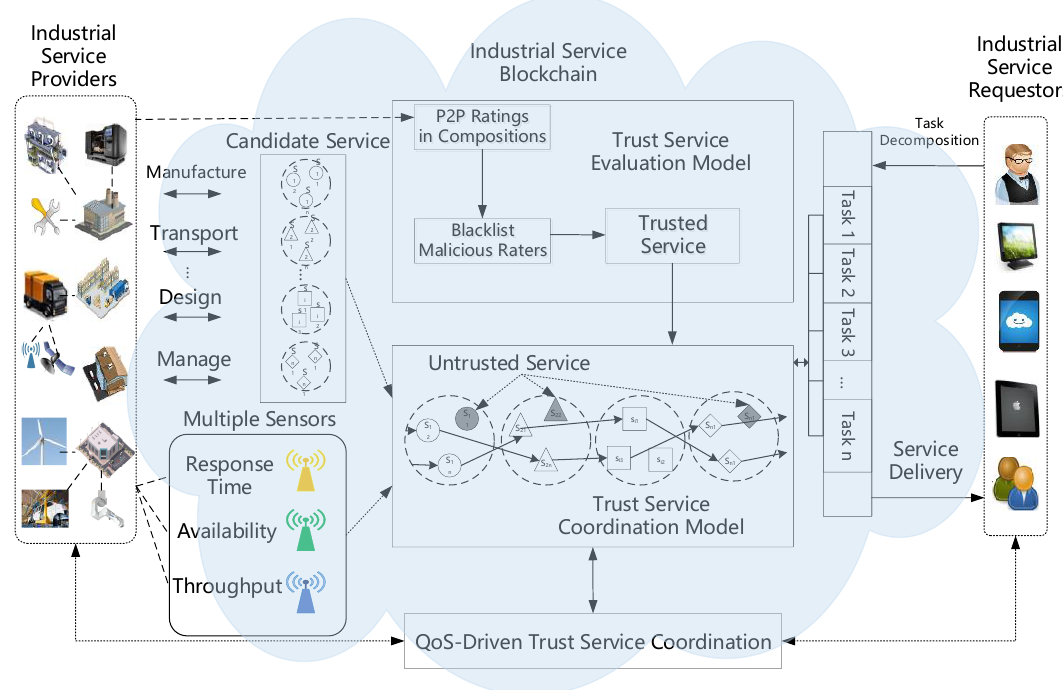
Figure 1. Adaptive trust service coordination framework in the industrial internet of things (IIoT). QoS — quality of service.